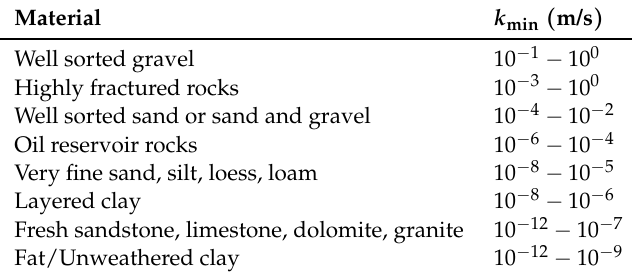
Table 2. Hydraulic conductivity ( k min ) values for different materials